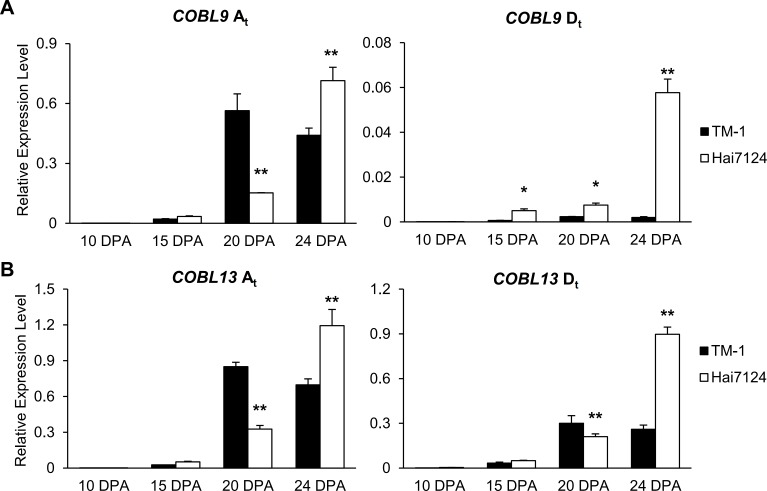
qRT-PCR analysis of COBL9 (A) and COBL13 (B) during the fiber development stages in TM-1 and Hai7124.The At and Dt were derived from A-subgenome and D-subgenome specific in tetraploid cotton species respectively. The Y axis indicated relative expression levels and the X axis indicated the different fiber development stages. “*” and “**” denoted the differences at P < 0.05 and P < 0.01 between TM-1 and Hai7124 respectively.